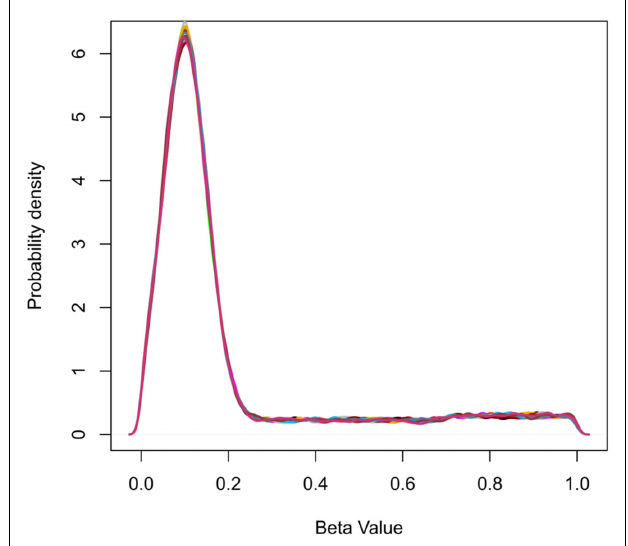
FIGURE 2 | Probability density plots showing the frequency distribution of beta-values for simulated data. The peak at beta-value at approximately 0.1 represents the abundance of hypomethylated CpGs in CpG islands.